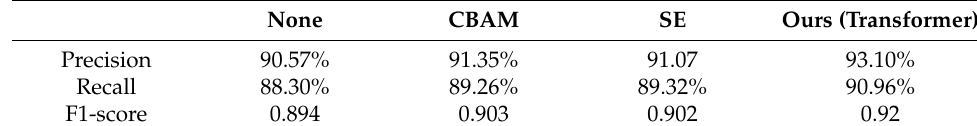
Table 11. Defect detection results of different attention mechanisms.